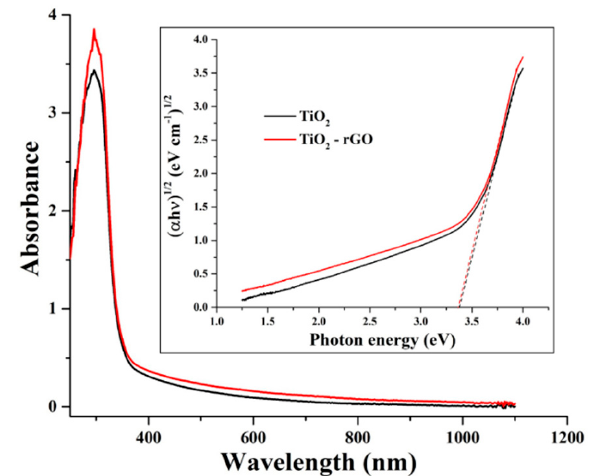
Figure 4. The absorbance of TiO 2 and TiO 2 –rGO films. Inset shows bandgap determination using a Tauc method.